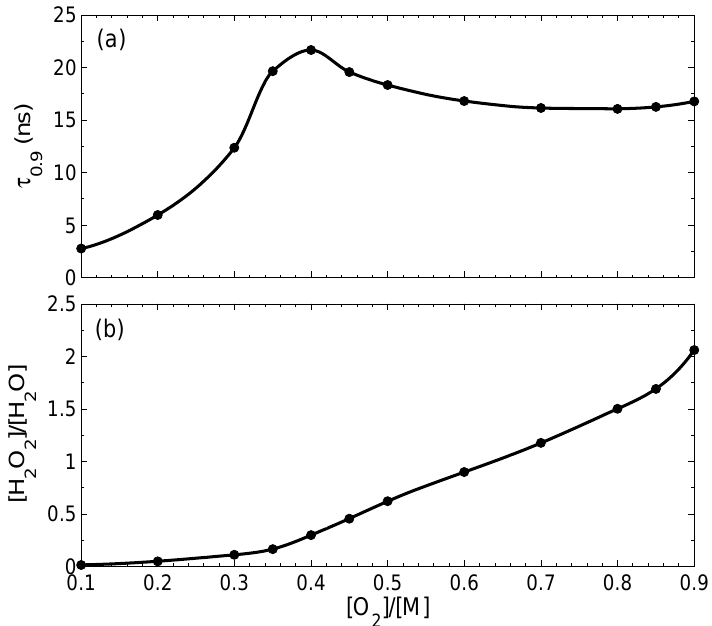
Figure 3. Dependence on the initial concentration of oxygen at a fixed value of the total concentration [ H ] + [ O ] = [ M ] . Dots present the points of actual calculation, but smooth curves are drawn by 2 2 0 cubic interpolation. ( a ) Time needed to reach the steady state; ( b ) Relative concentration of hydrogen peroxide with respect to